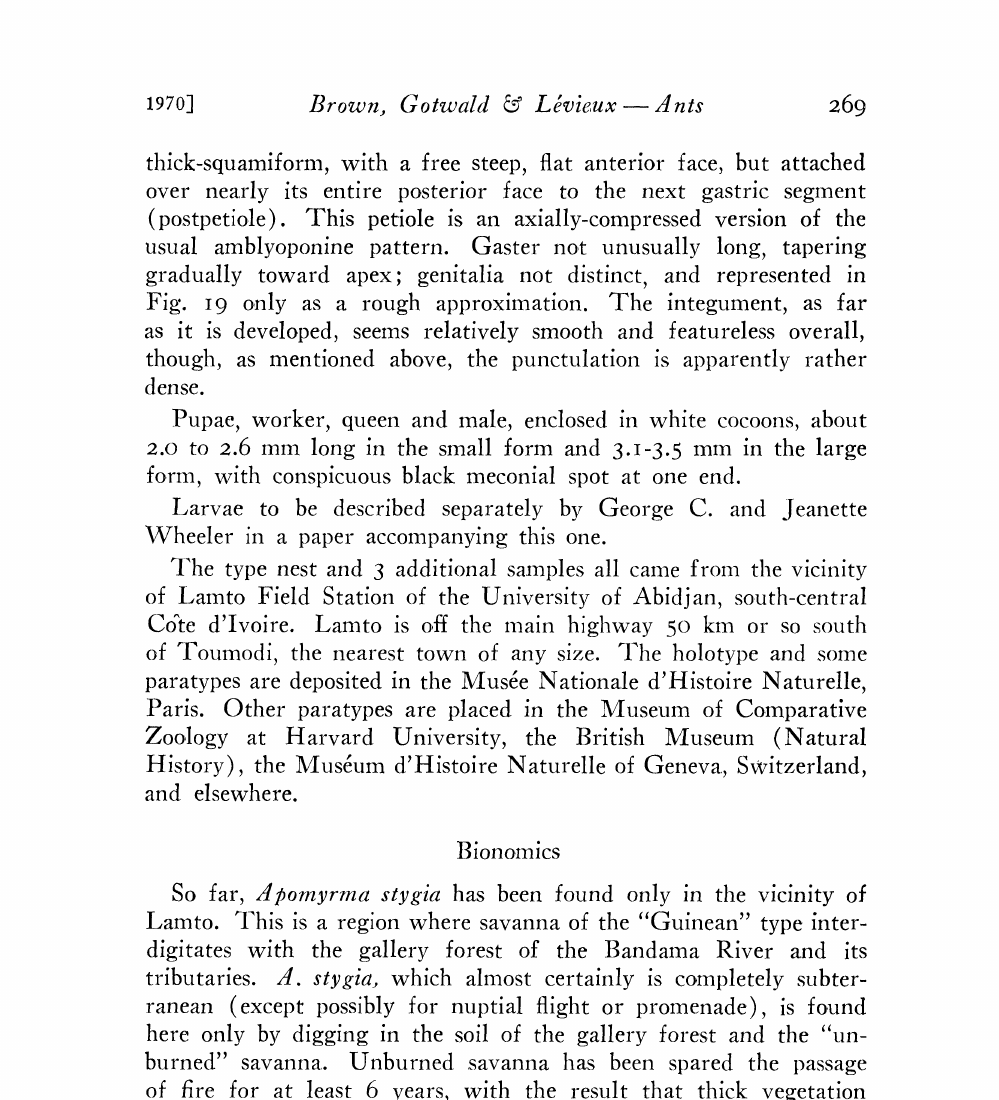
Fig. 12, labium with left labial palpus, lateral